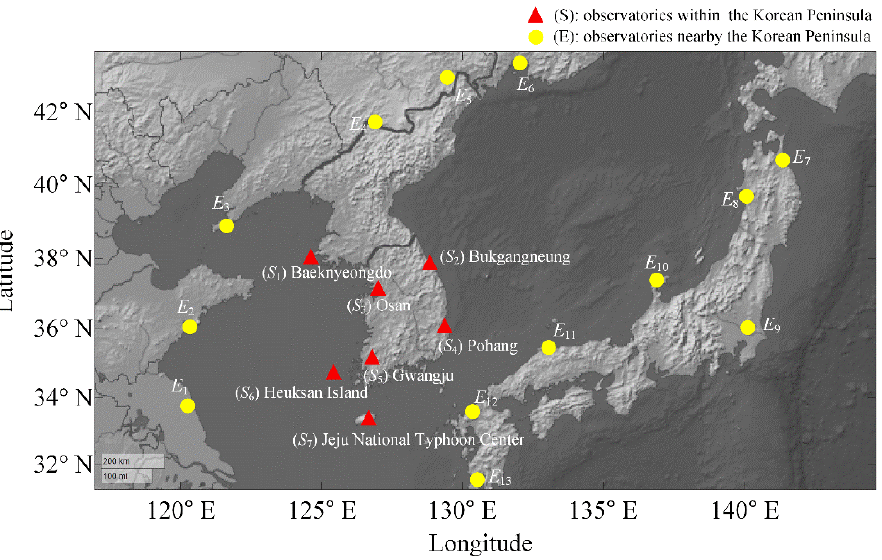
Figure 1. Locations of the twenty meteorological observatories inside and around the Korean Pen- insula.